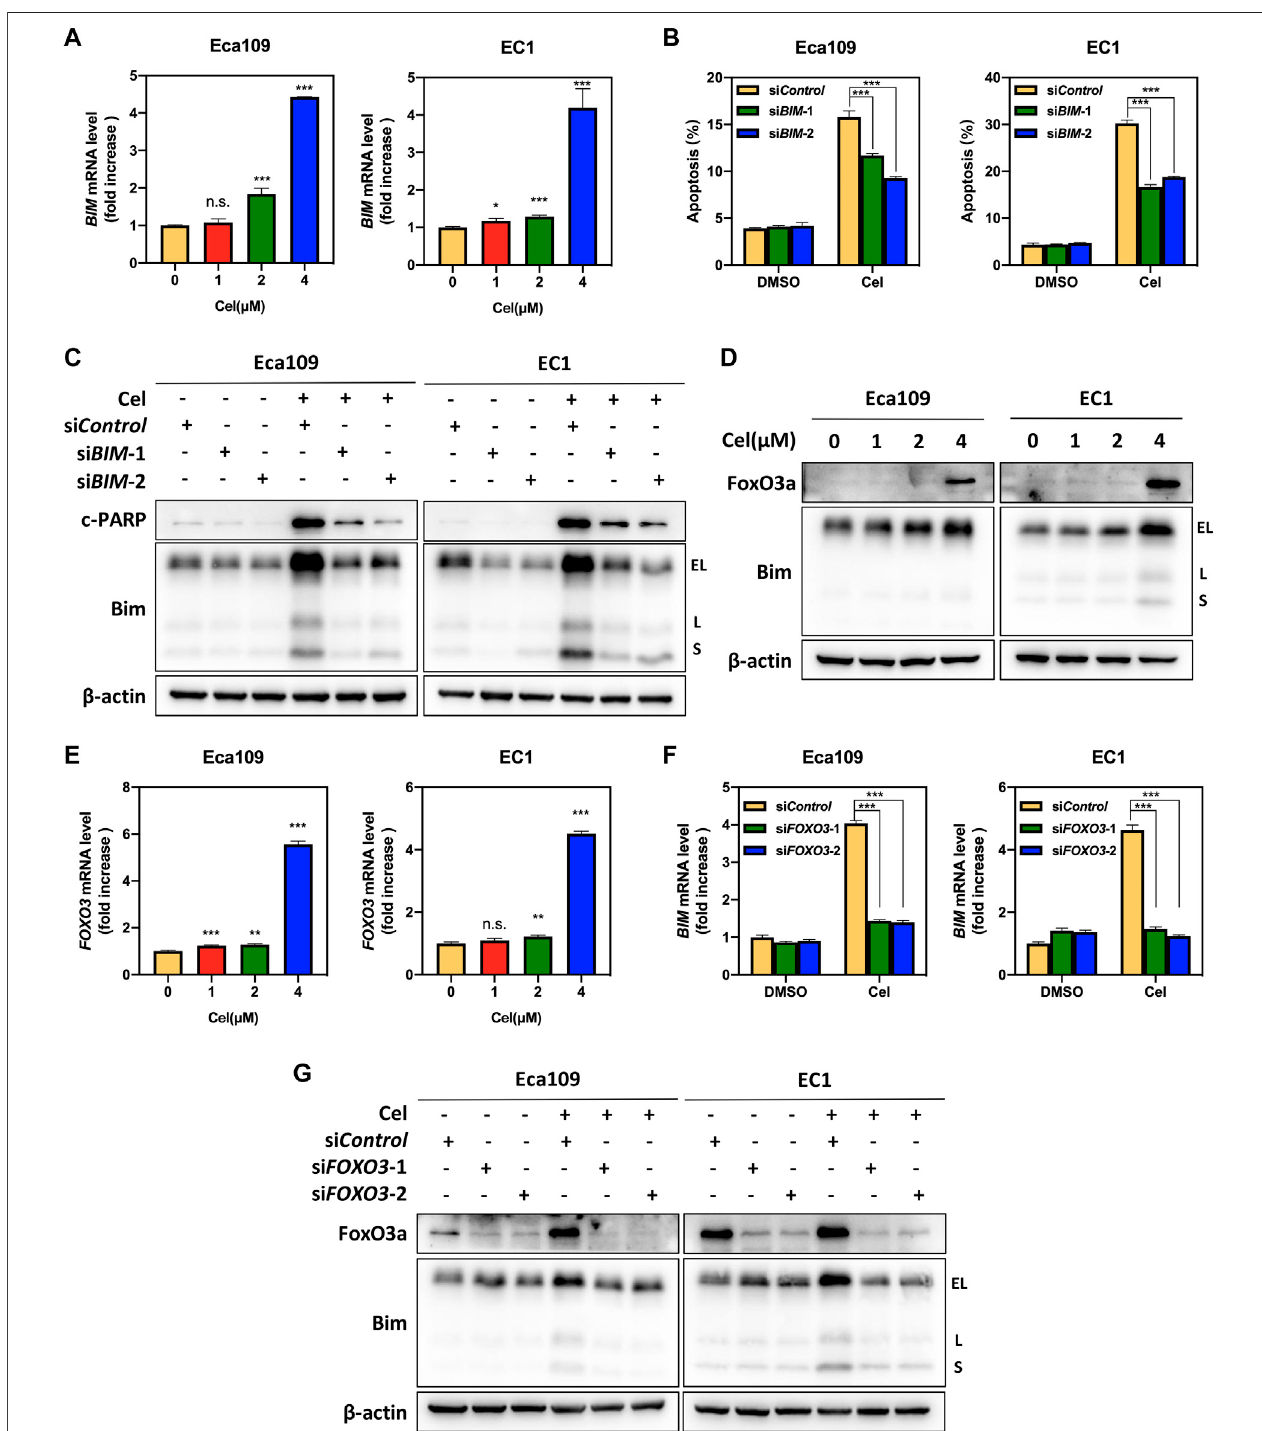
FIGURE 5 | FoxO3a meditated celastrol-induced Bim upregulation. (A) Celastrol increased the mRNA level of BIM . Eca109 and EC1 cells were treated with 1, 2, and 4 μ M of celastrol or DMSO for 24 h. The mRNA level of BIM was determined by real-time PCR. (B,C) Knockdown of Bim inhibited apoptosis induced by celastrol. Eca109 and EC1 cells were transfected with control or si BIM for 72 h, and then treated with 4 μ M celastrol or DMSO for 24 h. Apoptosis induction was quanti fi ed by Annexin V-FITC/PI double-staining analysis. Cell lysates were analyzed by Western blotting using speci fi c antibodies against c-PARP and Bim with β -actin as a loadingcontrol.ThreemajorBimisoformswerecreatedbyalternativesplicing:BimS,BimL,andBimEL. (D,E) CelastrolinducedtheupregulationofFoxO3a.Eca109and EC1 cells were treated with 1, 2, and 4 μ M of celastrol or DMSO for 24 h, and cell lysates were analyzed by Western blotting with an antibody against Bim and FoxO3a